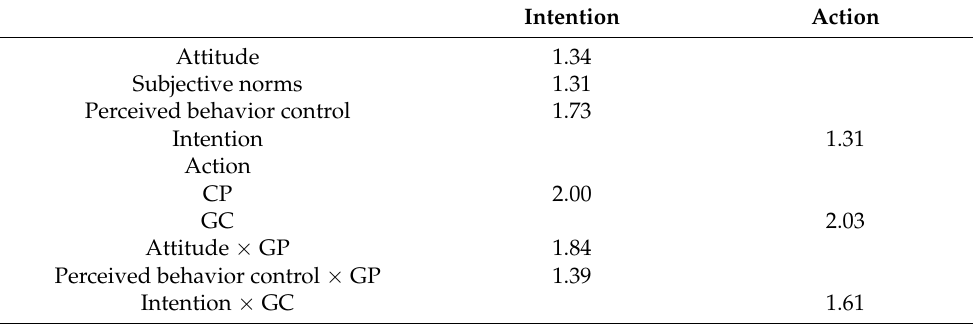
Table 4. Collinearity statistics (variance inflation factor